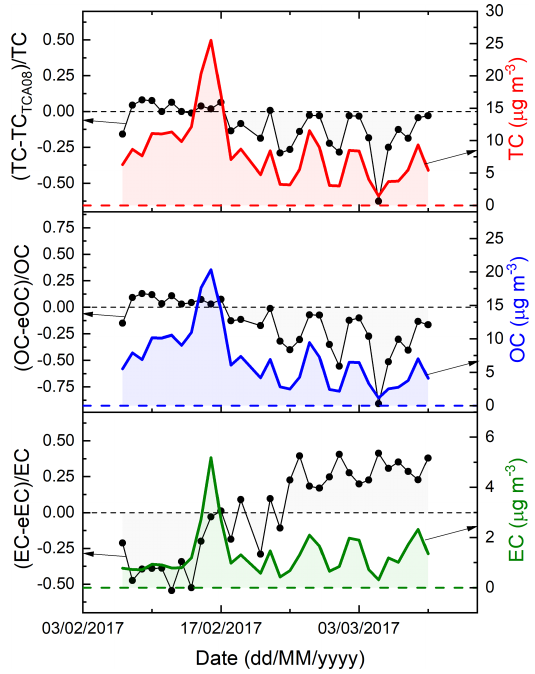
Figure 9. Left y axis: relative difference between TC, OC and EC (see Eq. 6) measured on 24h filters by conventional OC–EC method and TC TCA08 , TC − b BC and b BC measured online by TCA08 at 1h time resolution and AE33 at 1min time resolution and then av- eraged over 24h. Right y axis: the absolute concentrations of TC, OC and EC (red, blue and green line, respectively) are shown for easier comparison.